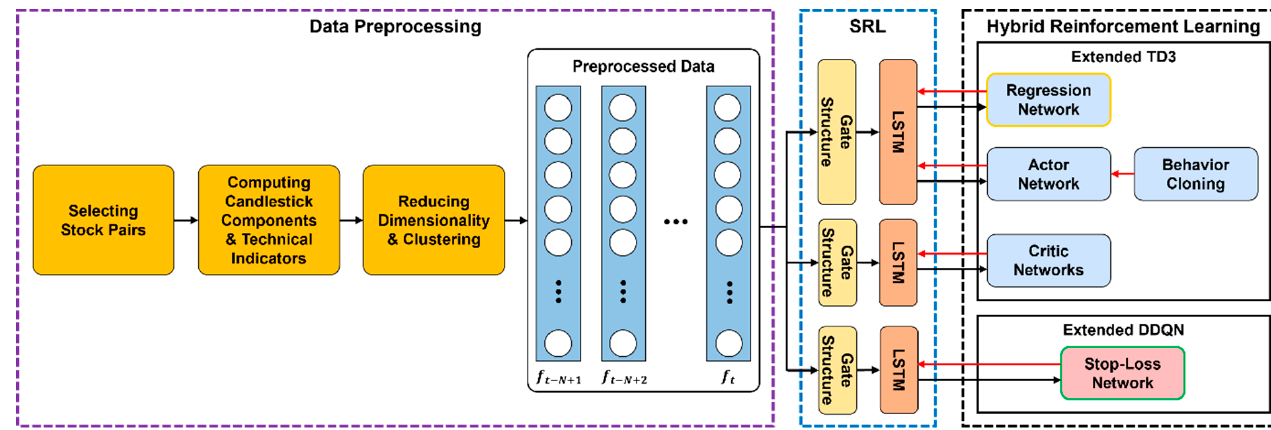
Figure 3. Architecture of the proposed